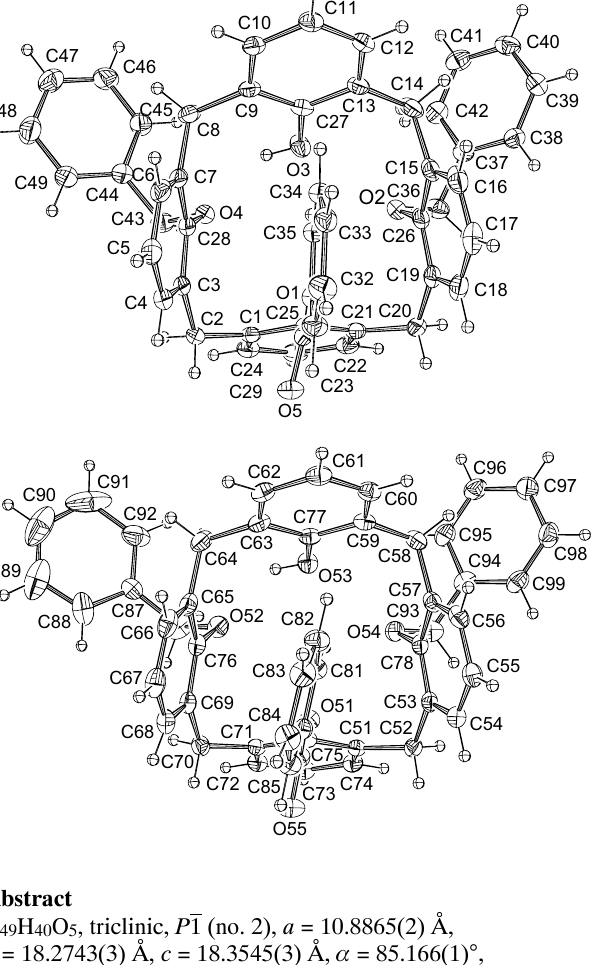
three c a lix a rene rings is the one be a ring the benzoyl group. T he dihedr a l a ngle between the two benzyl-substituted phenolic rings is 39.57(8)° in molecule 1 a nd 33.95(9)° in molecule 2, while the interpl a ne a ngles between the other two dist a l rings of the 2. I n molecule 1, the O 3/ O 2 a nd O 3/ O 4 sep a r a tions of 2.89 Å a nd 2.76 Å , respectively, a re e a ch consistent with the form a tion of a hydrogen bond involving the O 2 hydroxyl group. A simil a r situ a - tion is observed in the second c a lix a rene. I n both molecules the benzoyl pl a ne is ne a rly perpendicul a r to the phenoxy ring to which it is a ppended, a nd is s a ndwiched between two f a cing